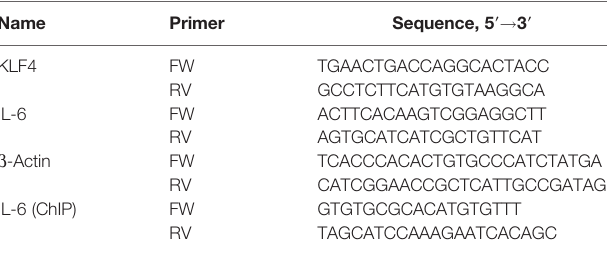
TABLE 1 | Speci fi c primers used in PCR